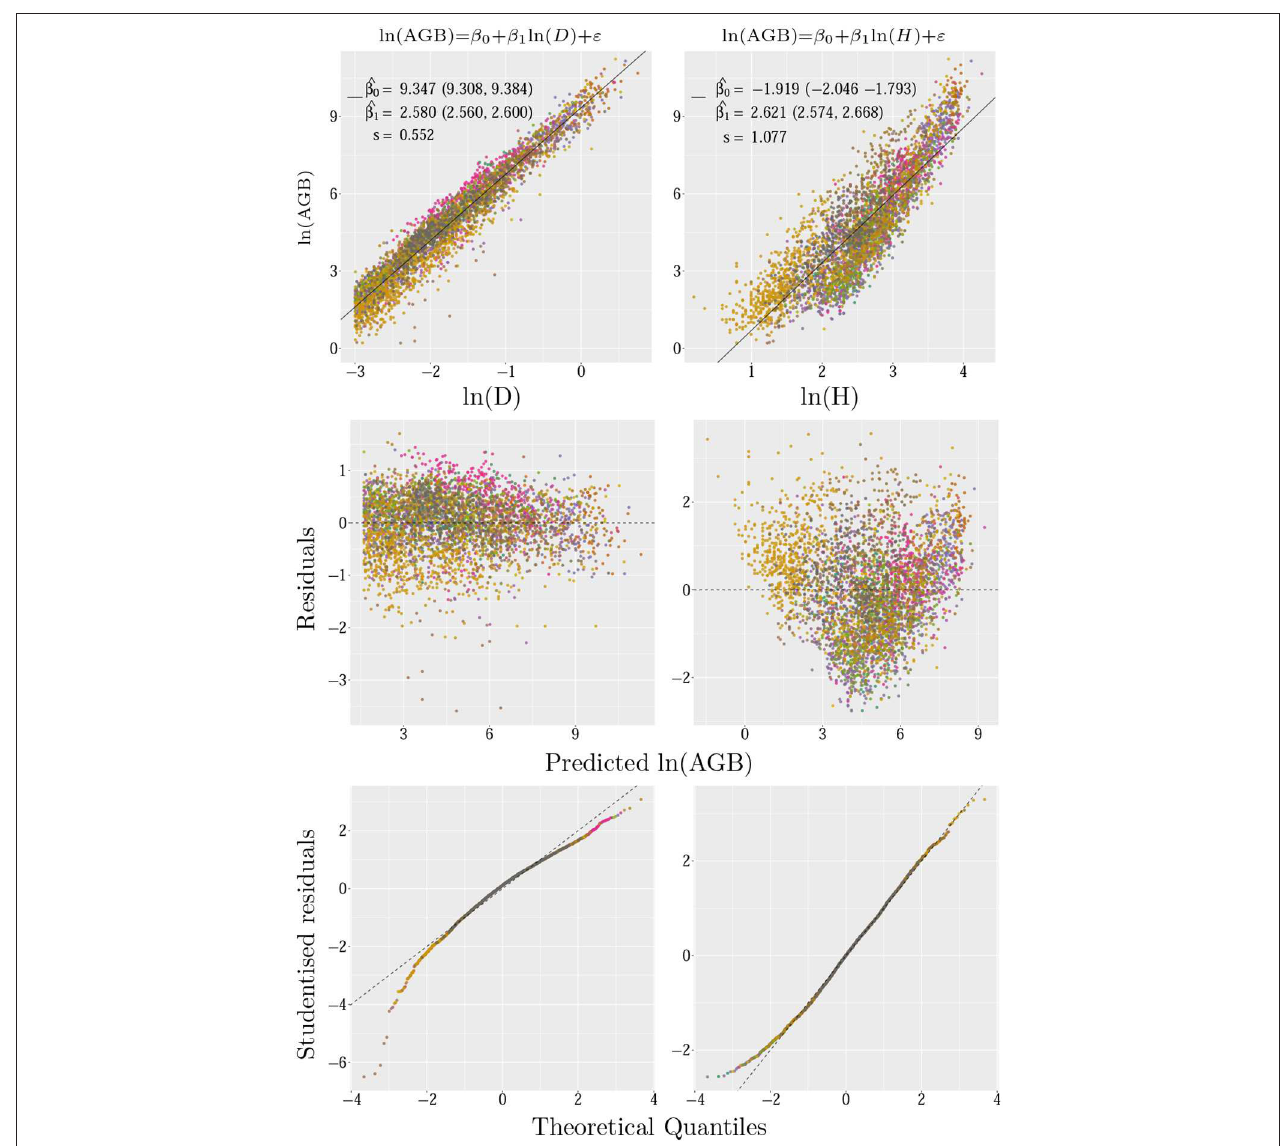
FIGURE 3 | The two bivariate pan-tropical models. Left: AGB = f ( D ), right: AGB = f ( H ). The upper subfigures present both models overlain on the calibration data (which are uniquely colored by each underlying study contributing to the full dataset). Provided in the upper subfigures are the OLS estimates of the population parameters, the bootstrapped BCa 95% confidence intervals ( N = 10000), and the standard error of the regression. The middle subfigures illustrate the variance of residuals across predicted B for both models, and the lower subfigures present a quantile-quantile plot comparing the distribution of studentised residuals with the expected normal distribution. It is noted that residuals from both models have non–constant variance and are non–normally